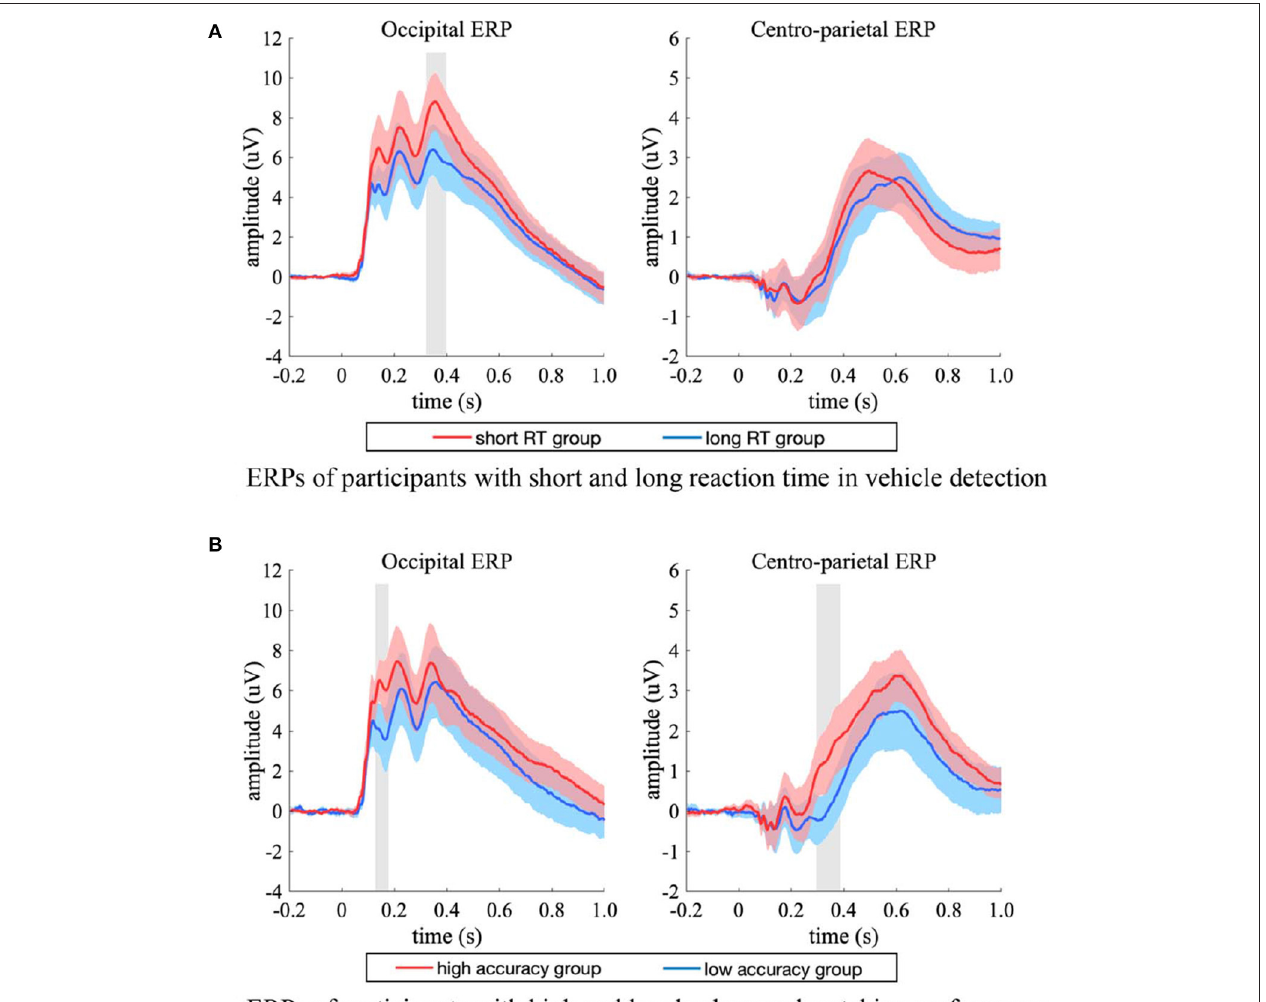
FIGURE 8 | ERP differences between participants with high and low performance. (A) The occipital (left) and centro-parietal (right) ERPs of short (red) and long (blue) RT groups, the ERPs were from both the single-task and the dual-task. (B) The occipital (left) and centro-parietal (right) ERPs of high (red) and low (blue) accuracy groups, the ERPs were from the dual-task. The shaded area indicates 95% confidence interval. Shaded gray regions denote the time intervals when there were significant differences between the two groups ( p < 0.05, two-sample t -test, FDR